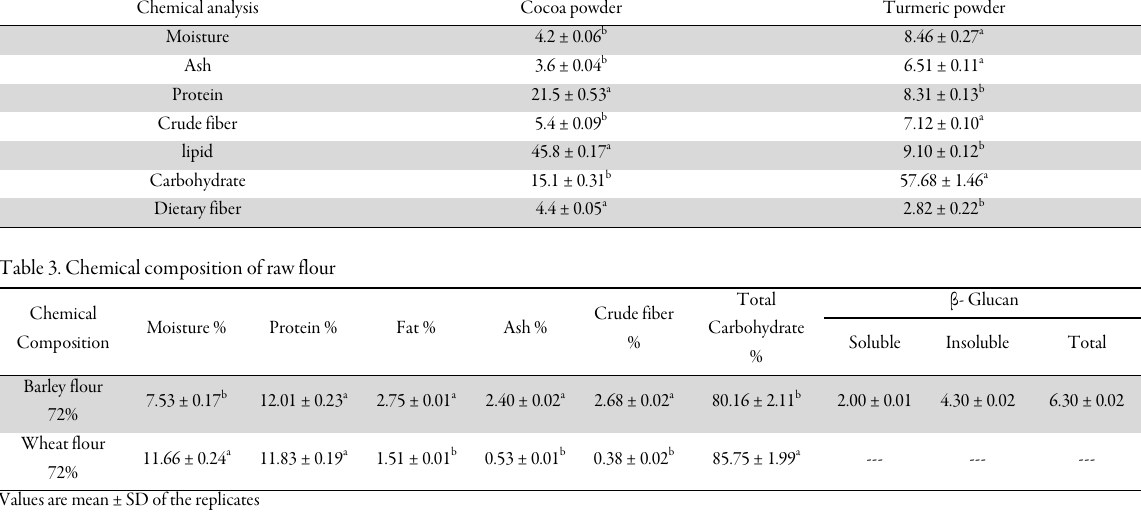
Table 2. Chemical composition of cocoa and turmeric powder (%) Chemical analysis